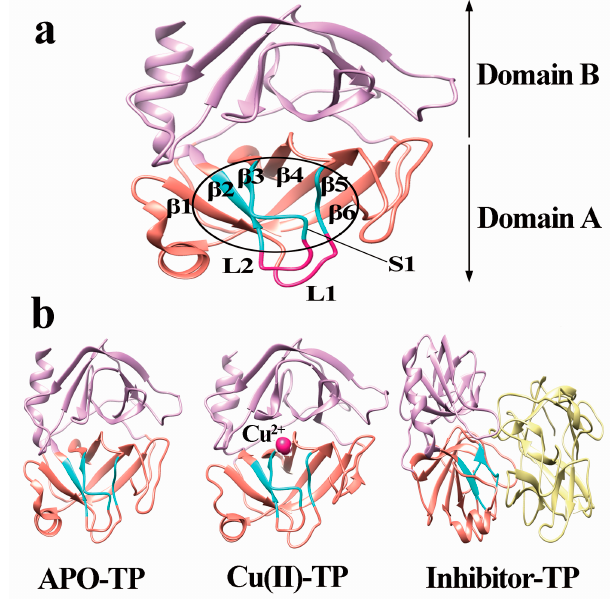
Figure 3. Three dimensional of trypsin protein. ( a ) Structure of S1 pocket; ( b ) Structure of APO ‐ TP, Cu(II) ‐ TP and Inhibitor ‐ TP. Domain A of trypsin is shown as purple ribbon and domain B as golden ribbon. Active site residues of trypsin are shown with β‐ sheets in blue ( β 2, β 3, β 4, β 5 and β 6) and loops (L1 and L2) in magenta. Cu ions are presented as a deep pink ball and STI is presented as golden ribbon.